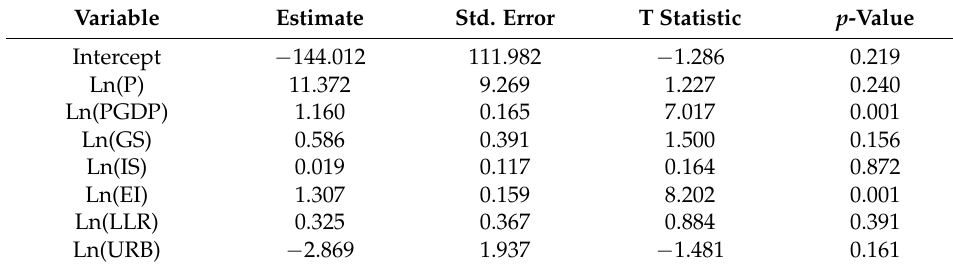
Table 2. The results of OLS.